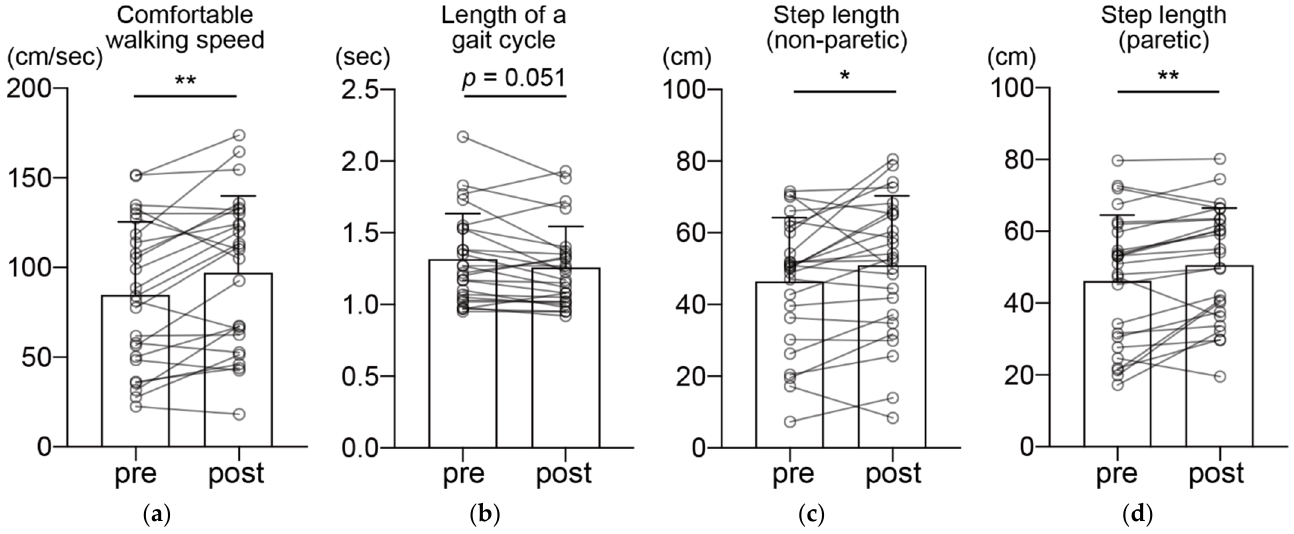
Figure 2. Pre- and post-intervention comparison of gait parameters during comfortable walking speed: ( a ) comfortable walking speed, ( b ) length of a gait cycle, ( c ) non-paretic step length, and ( d ) paretic step length. The connected plots show the pre- and post-intervention data of a subject. Bar graphs show the mean value. * p < 0.05, ** p < 0.01, error bar = SD, n = 25. There was no significant change in stride-length symmetry (paretic/non-paretic; pre, 1.07 ± 0.34, post, 1.11 ± 0.40, p > 0.99). Temporal asymmetry in the gait cycle, a